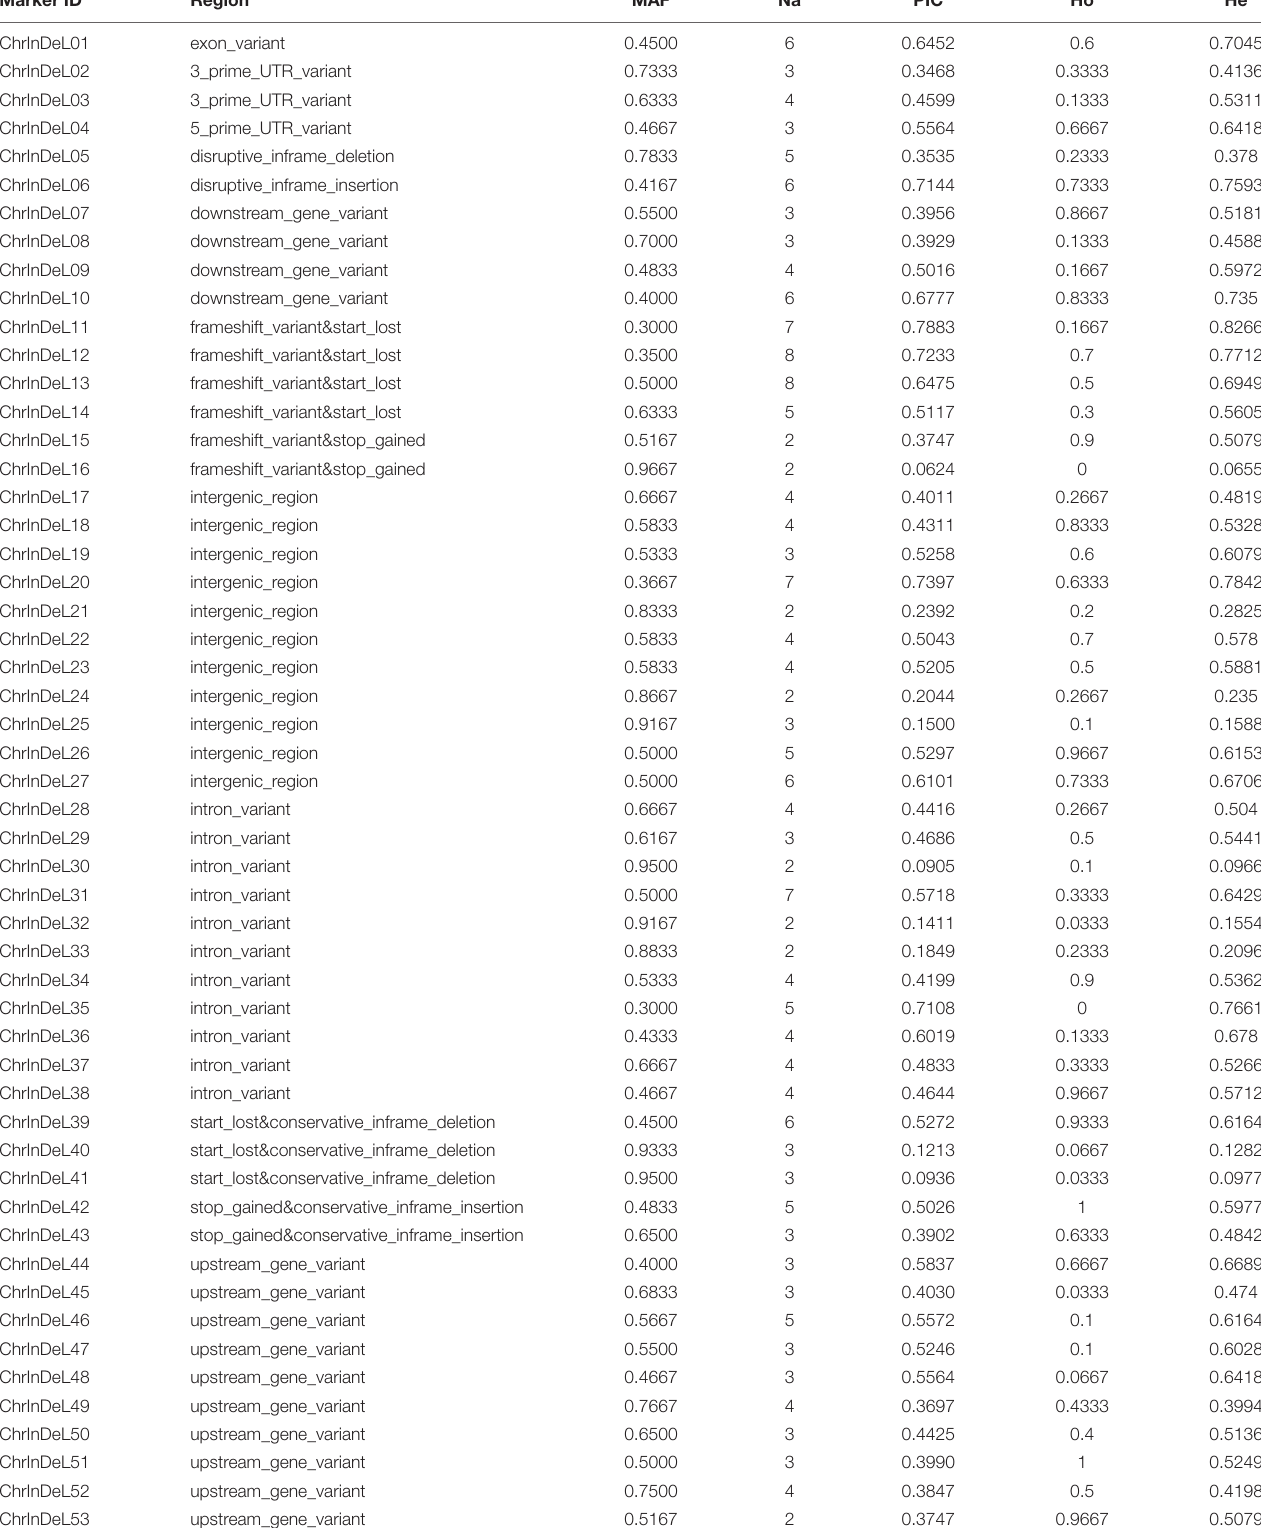
TABLE 2 | Characteristics of 53 newly developed indel markers. Marker ID